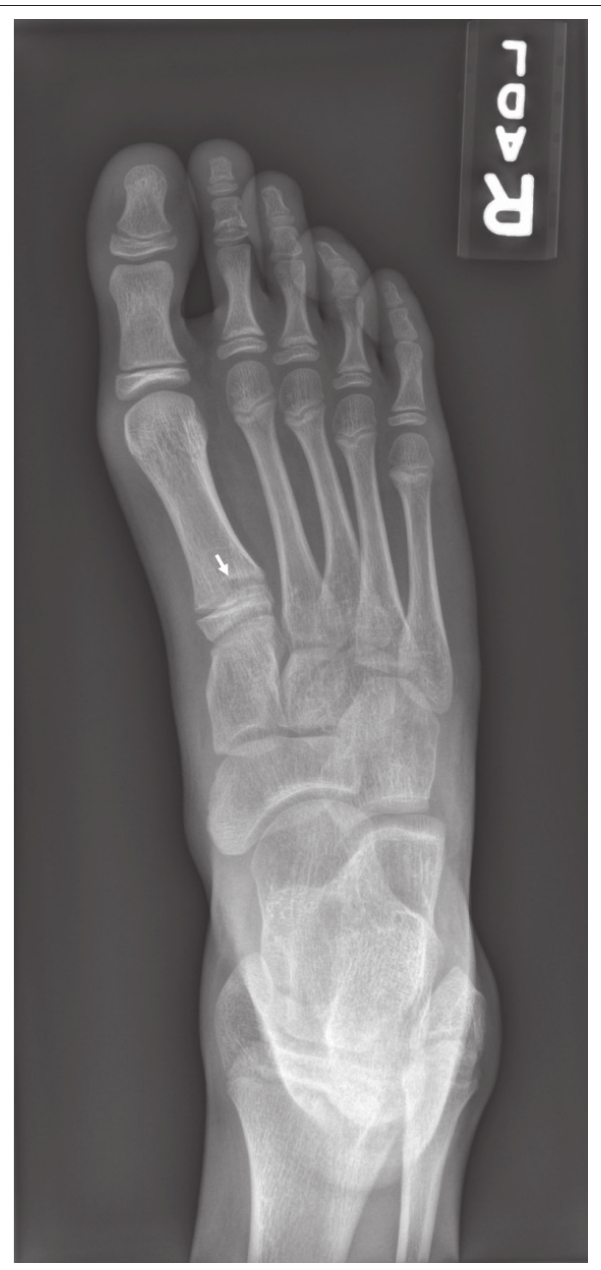
FIGURE 1: An 11-year-old female soccer player with lateral ankle and foot pain following a soccer injury. Frontal view of the foot shows subtle widening (arrow) of the physis of the great toe metatarsal. The remainder of the imaging examination is